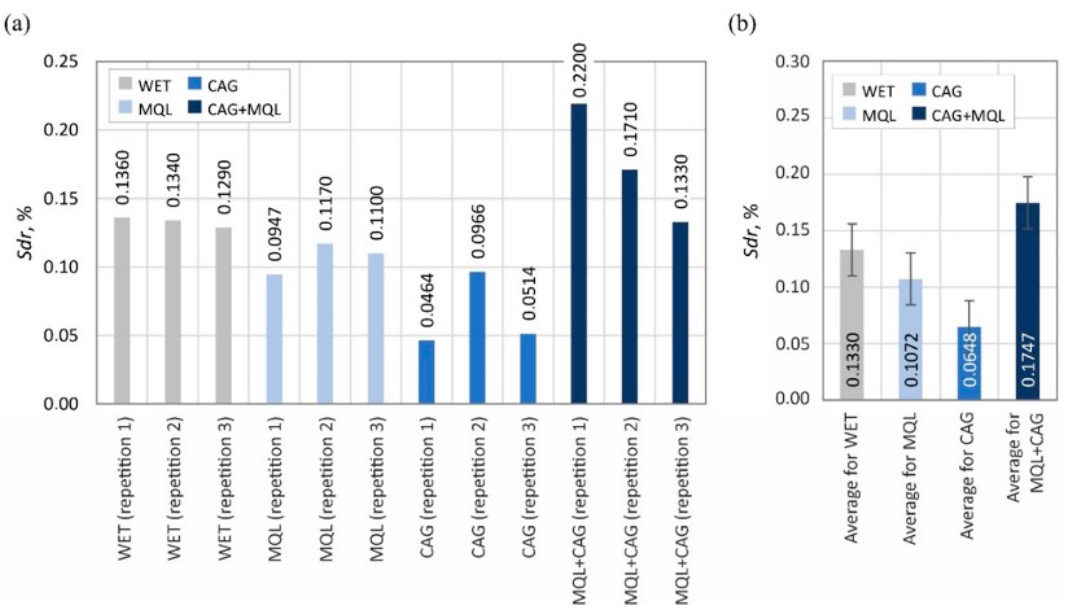
Figure 13. Chart of changes in the developed interfacial area ratio Sdr : ( a ) results for the twelve blades selected for the surface texture measurements; ( b ) mean values of the parameters divided by cooling and lubrication methods of the grinding zone used during the shaping of the blades (error bars represent the standard error equal to the standard deviation σ divided by the square root of the total number of samples).